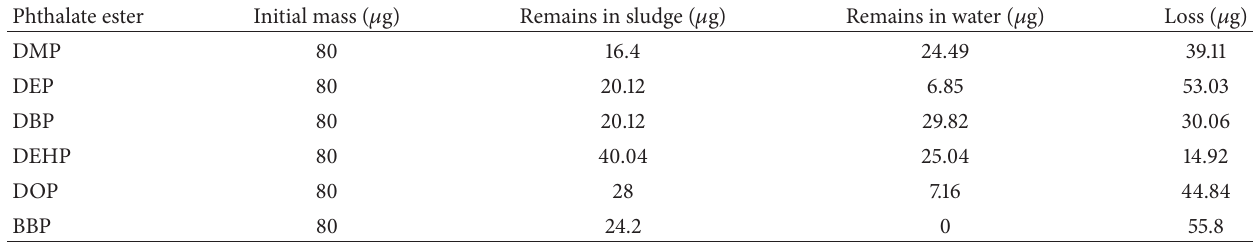
Table 3: Mass balance analysis in one-liter mixture solution.